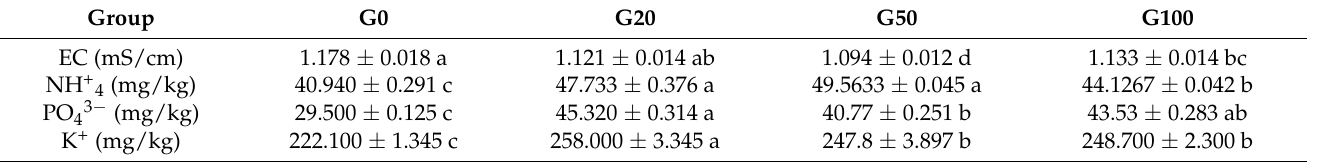
Table 2. Conductivity values and nutrient content of the eluent of drenched graphene-treated